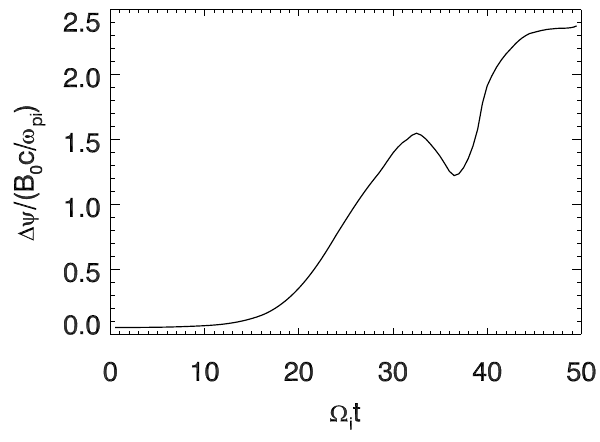
Fig. 5. Time evolution of the flux difference 1ψ in the reconnec- tion, where the magnetic flux 1ψ is defined as the flux difference between the position (26 . 6 c/ω pi , 0) and the first O line formed dur- ing the reconnection.